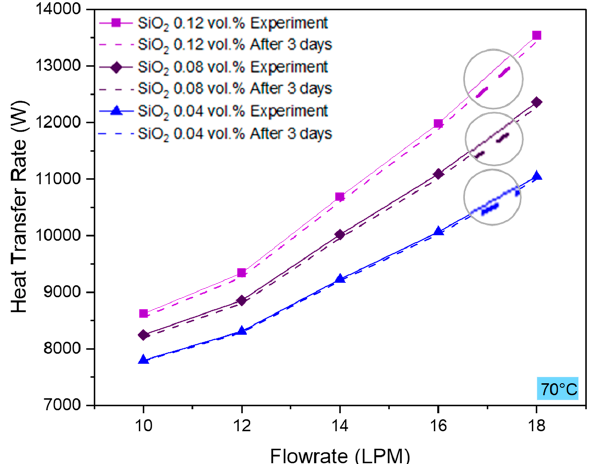
Figure 11. Experimental repeatability test results of the heat transfer rate performed after three days of initial experimentation.